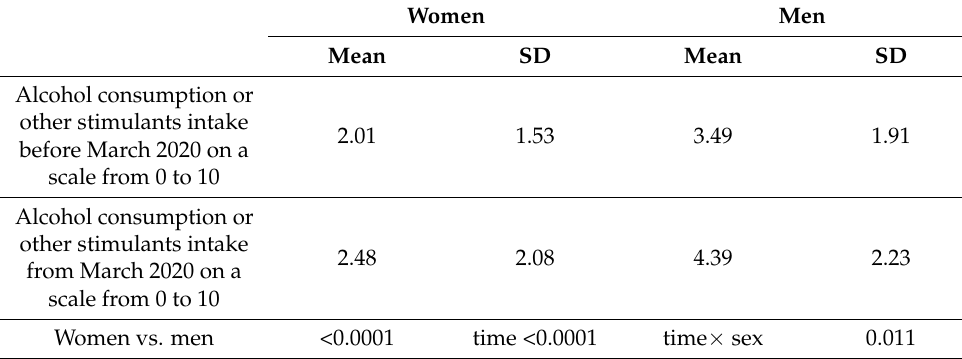
Table 7. Alcohol intake among groups.